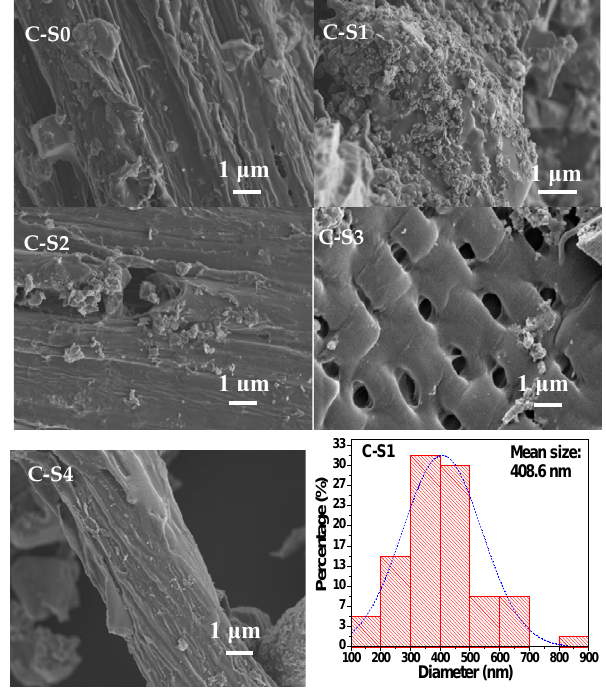
Figure 4. SEM images of C-S0, C-S1, C-S2, C-S3, C-S4, and the size distribution of C-S1.